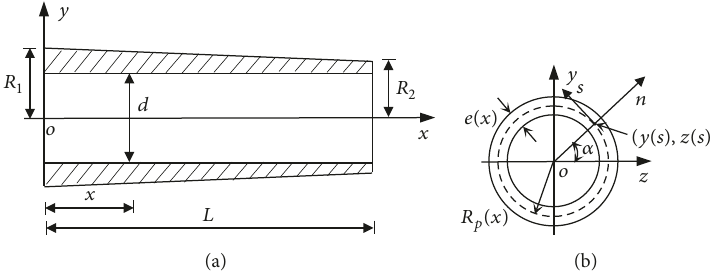
Figure 2: Geometry of rotating tapered cantilever beam with hollow circular cross-section and coordinate system.